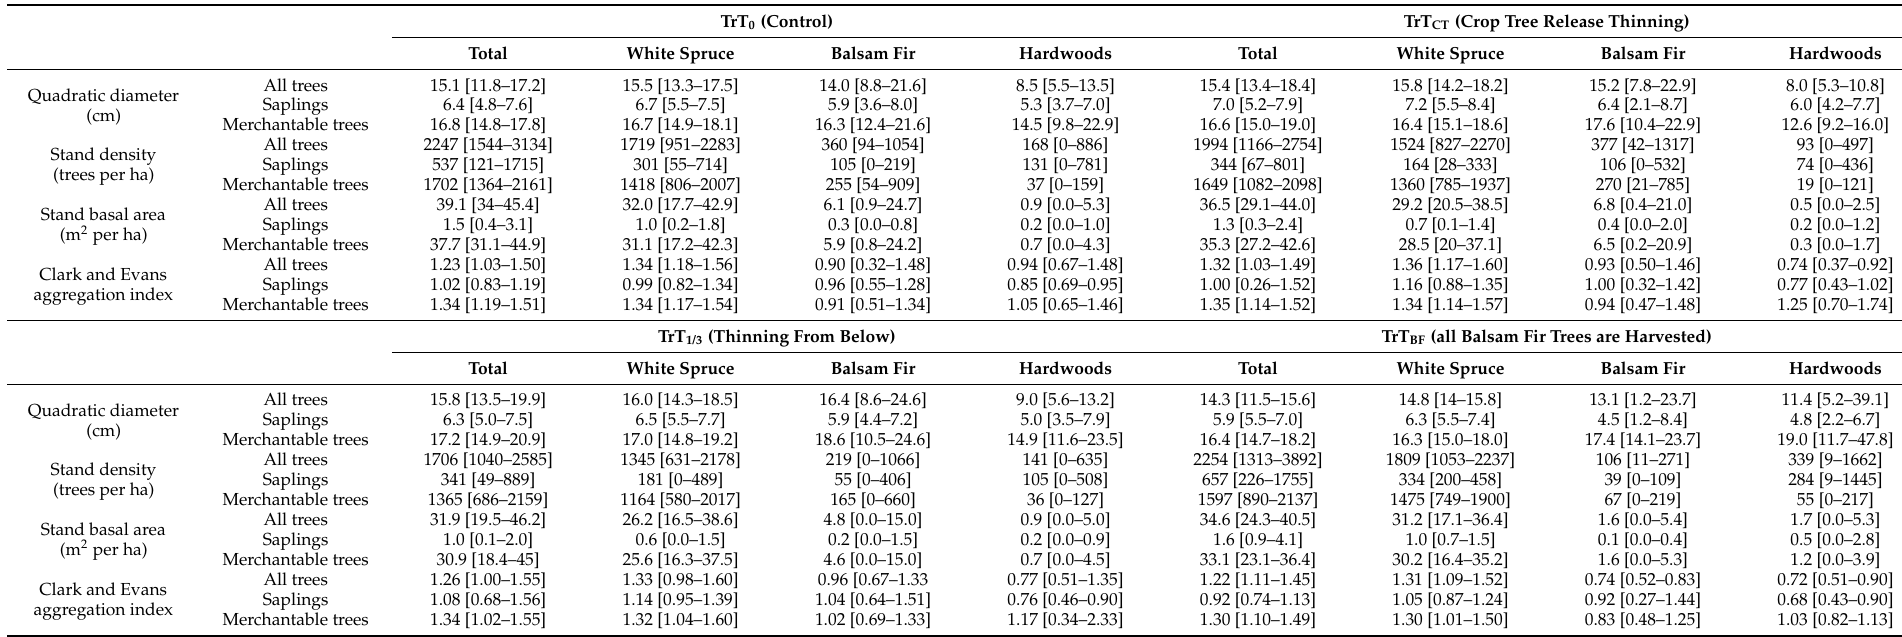
Table 1. Mean characteristics (minimum–maximum) of stands by treatment for all commercial species (total), white spruce, balsam fir, and